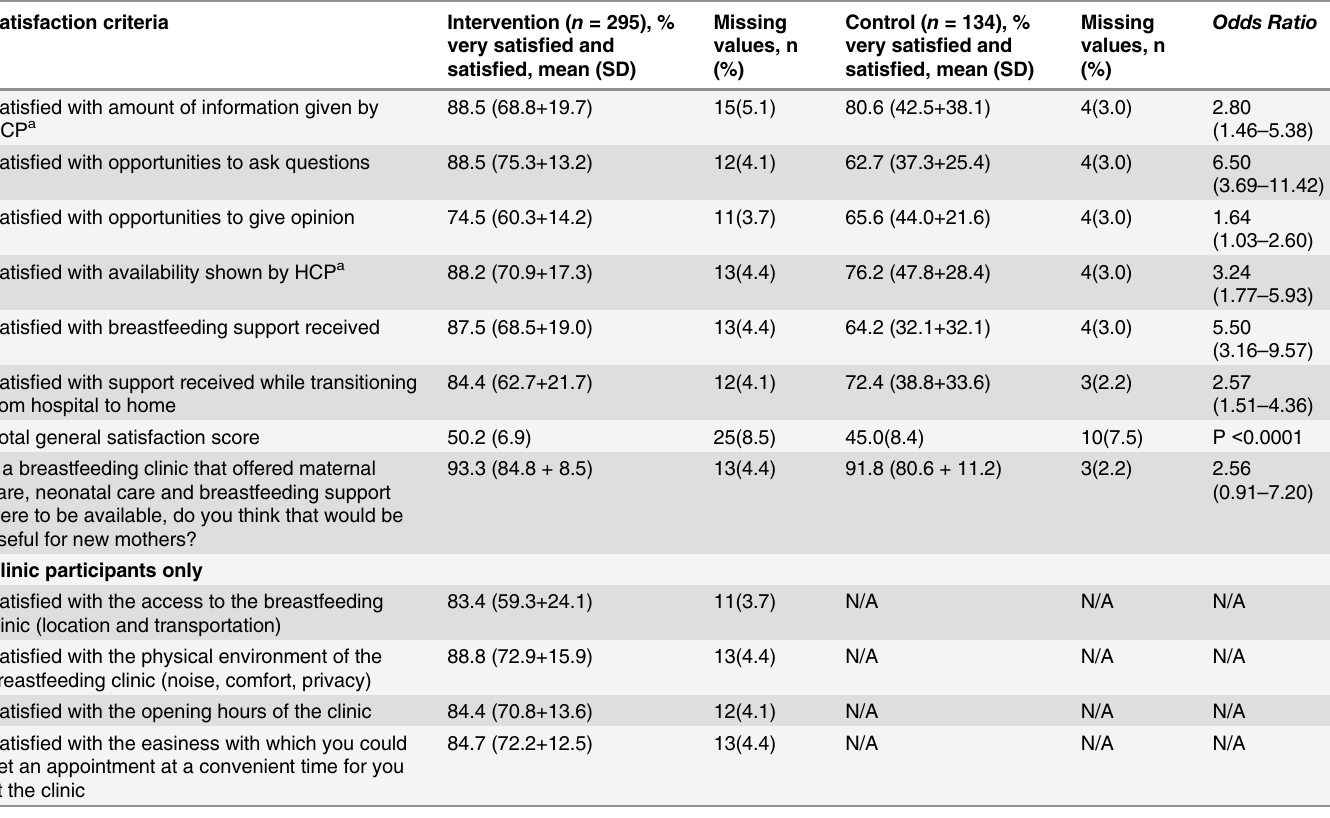
Table 7. Maternal Satisfaction.